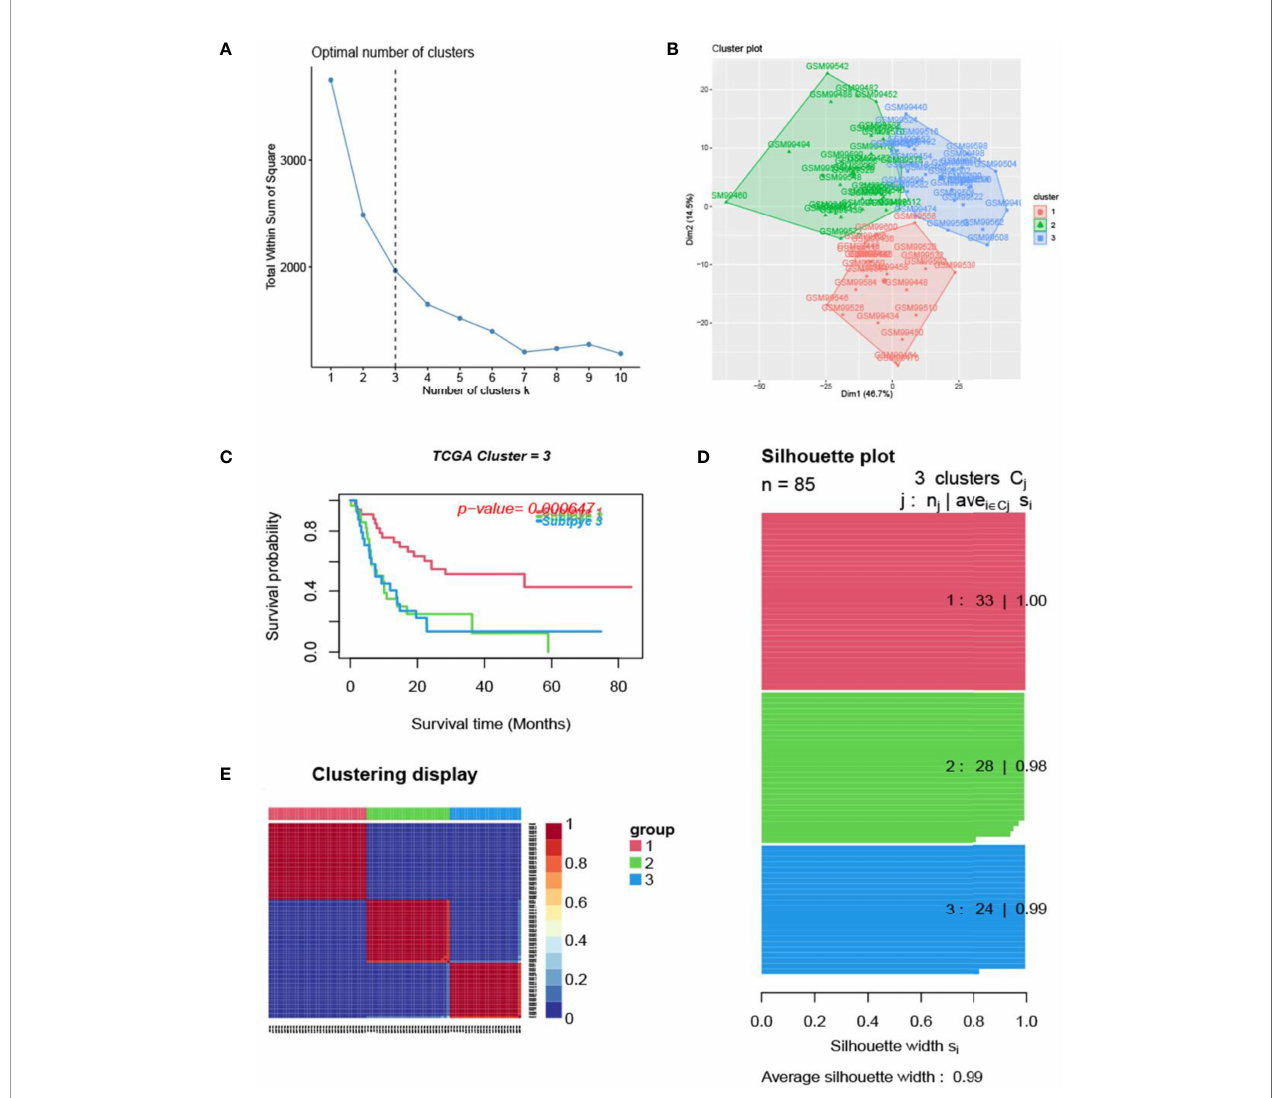
FIGURE 3 | Glioma subtype identi fi cation (GEO GSE4412). (A) Use the factoextra package to perform clusters analysis. (B) Sample composition diagram of the 3 cancer subtypes. (C) K-M curves of different cancer subtypes. (D) Cancer Subtypes ’ Silhouette width plots. (E) The clustering displays of the three cancer